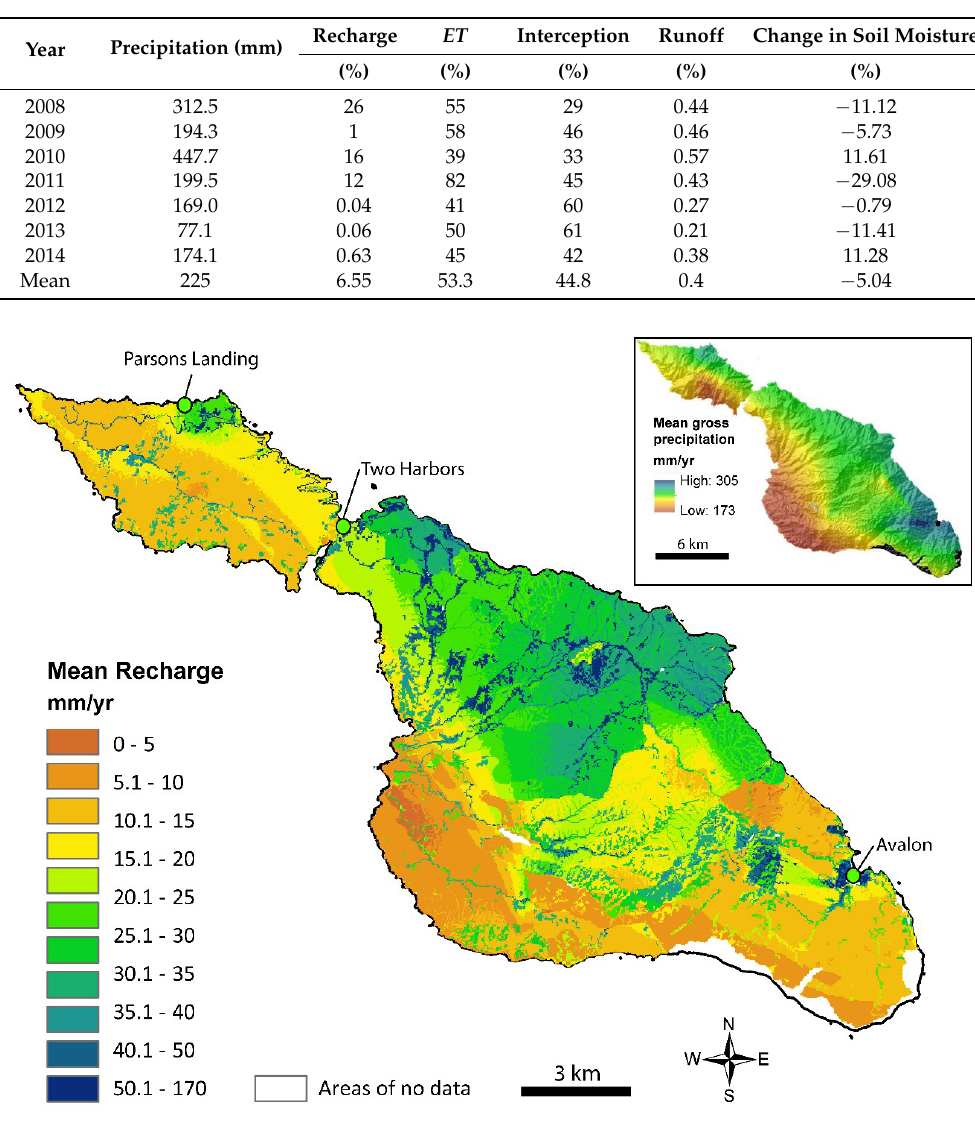
Table 6. Water Balance Parameters as % of Gross Precipitation.